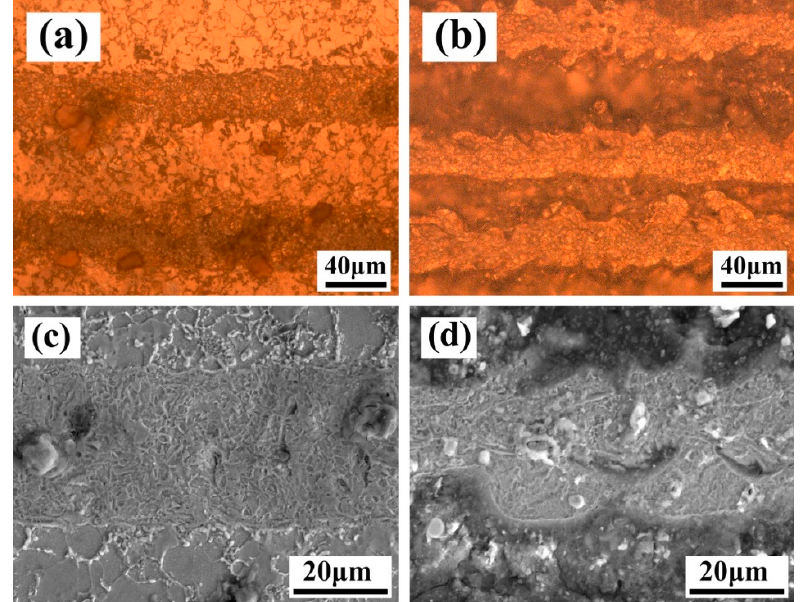
Figure 16. OM and SEM micrographs of the material surface after laser cleaning at different X-scanning speed. ( a ) 500 mm / s (OM); ( b ) 1000 mm / s (OM); ( c ) 500 mm / s (SEM); ( d ) 1000 mm / s (SEM).